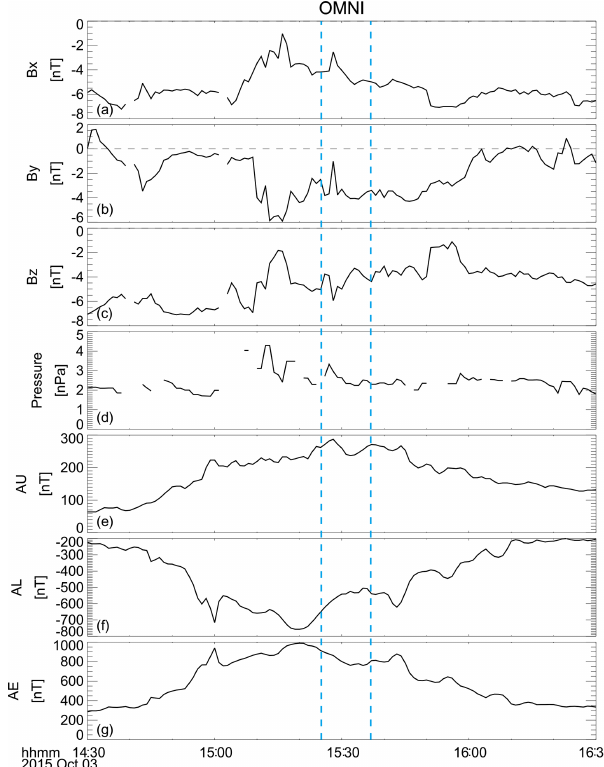
Figure 1. The three components of the IMF B x , B y , and B z in the Geocentric Solar Magnetospheric coordinates, solar wind dynamic pressure, as well as AU, AL, and AE indexes from CDAweb OMNI data. The two blue dashed lines indicate the interval of the magne- topause boundary layer